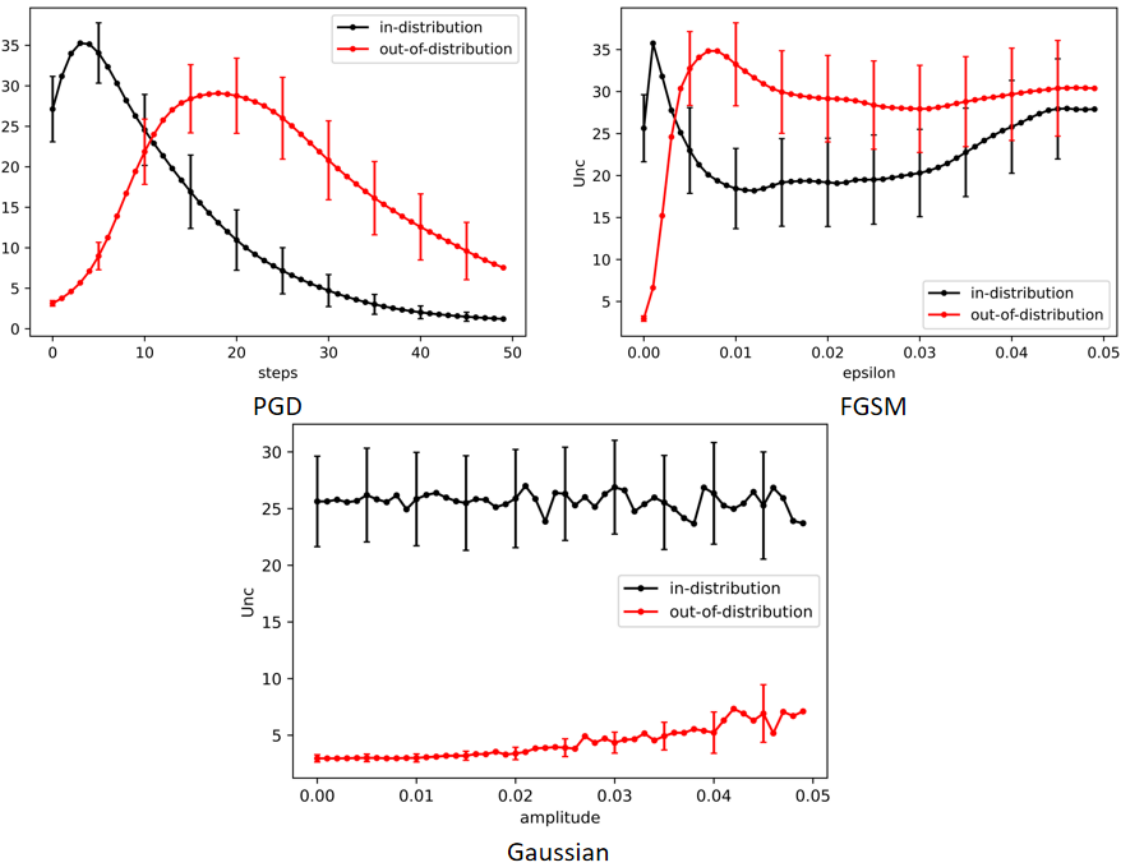
Figure 2. The trends of uncertainly calculation of the samples that have been misclassified by SOCD when applying different types of perturbation. We used SVHN as the ID dataset and CIFAR10 and CIFAR100 as the OOD